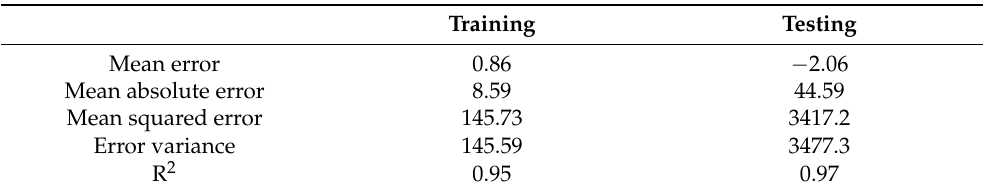
Table 1. Statistics of our suggested model’s training and testing data errors for predicting the price of gold.